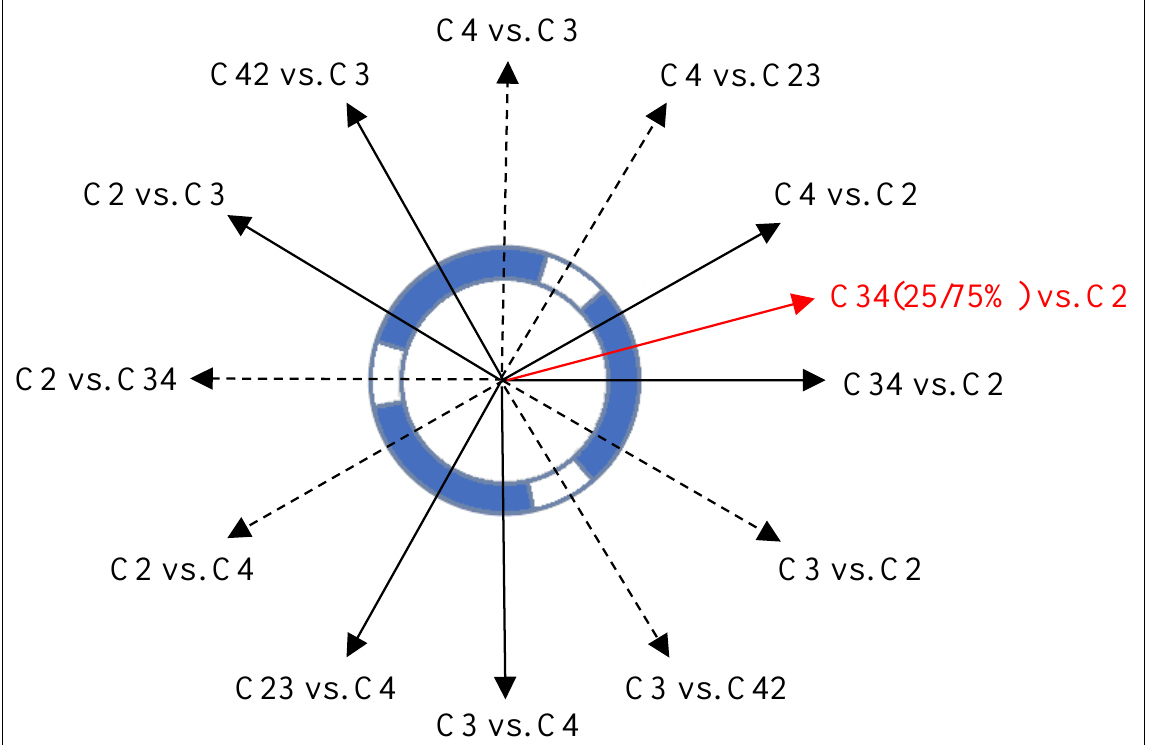
Figure 13. Bottom view of the electrode with arrows indicating the direction of current flow which is defined by the corresponding electrode configuration. Black solid arrows indicate the directions set by the electrode configurations investigated in this study. Dashed arrows indicate the direction of the currents by the corresponding change of anode and cathode contacts. The red arrow marks an example of a possible electrode configuration through MICC technology, which can be used to achieve finer